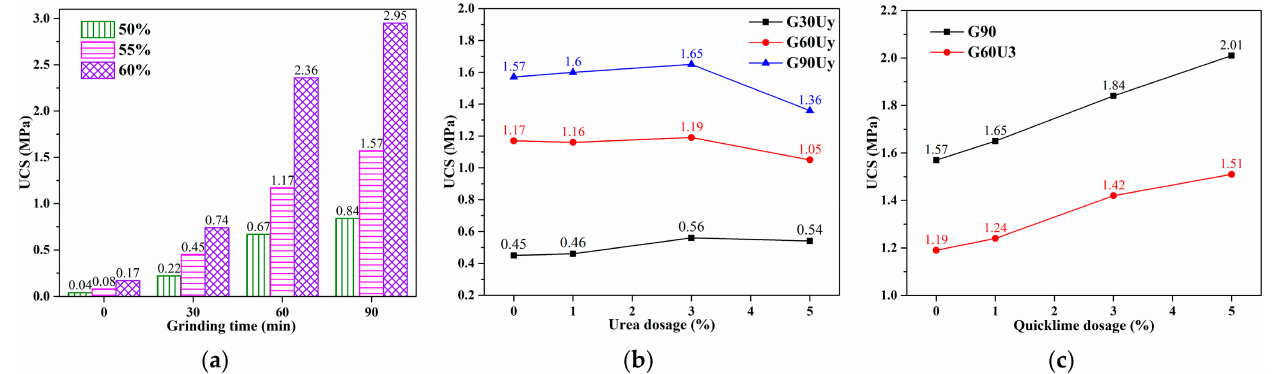
Figure 9. The UCS of Gx-based GBM-A1 ( a ), GxUy-based GBM-B1 ( b ), G90-based GBM-A2, and G60U3-based GBM-B2 ( c ) specimens after curing for 7 days.